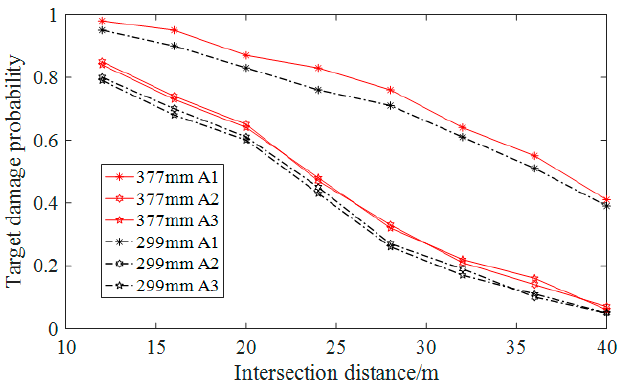
Figure 5. Variation curve of target damage probability at different intersection distances.